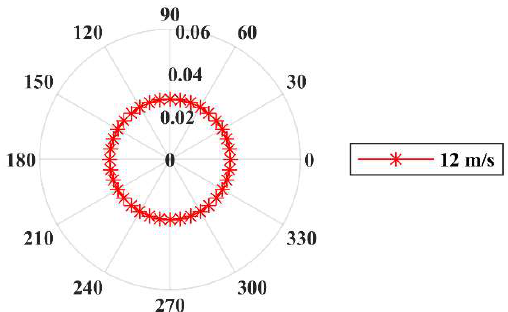
Figure 6. Probability of constant wind speed and variable wind directions.